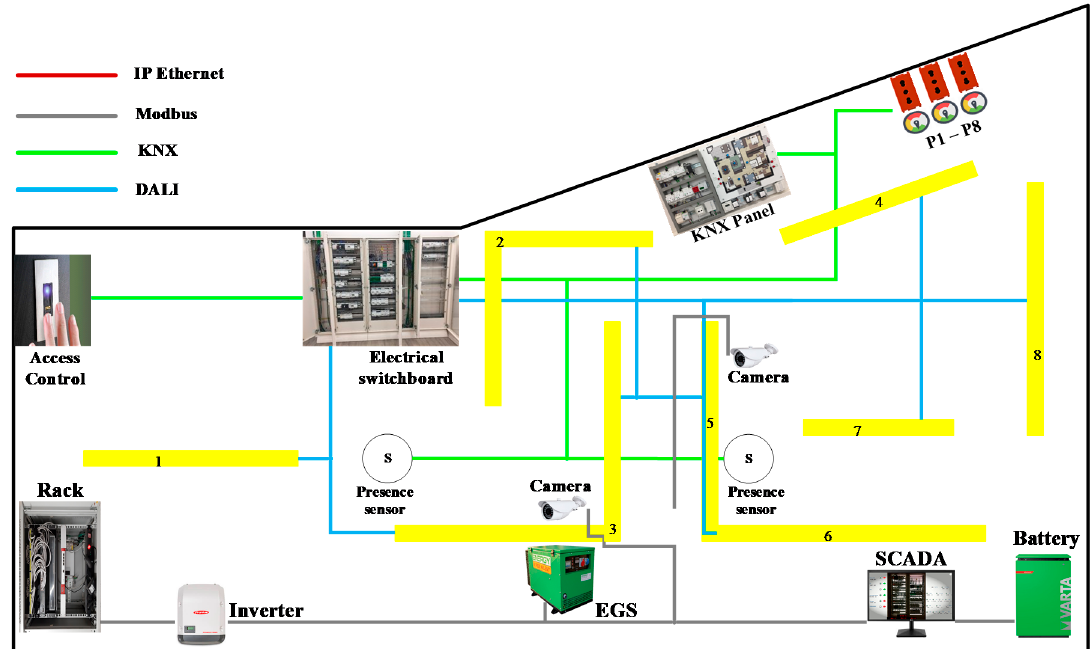
Figure 4. Physical disposition of the essential components in LAMBDA MG. 152